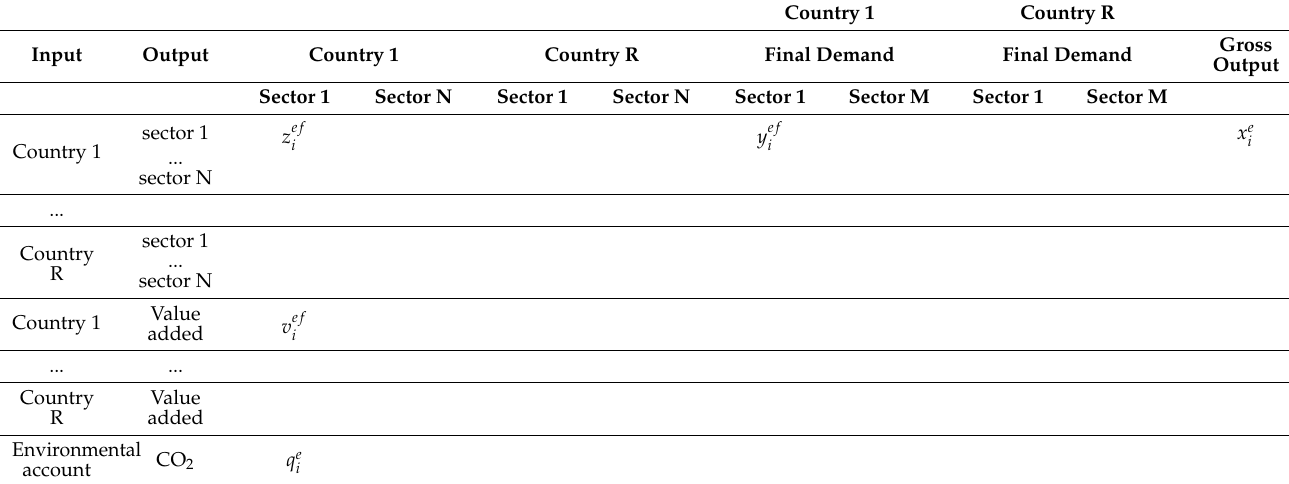
Table 1. MRIO table. The MRIO table is divided into R regions; each region has N sectors. Z represents intermediate inputs, Y represents final demand, X represents final output, V represents added value, and Q represents direct carbon